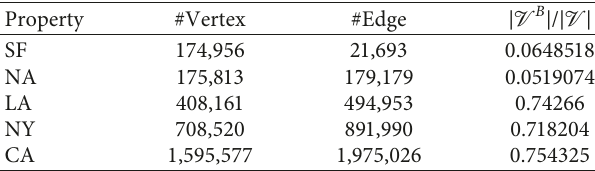
Table 3: The property of real life datasets.